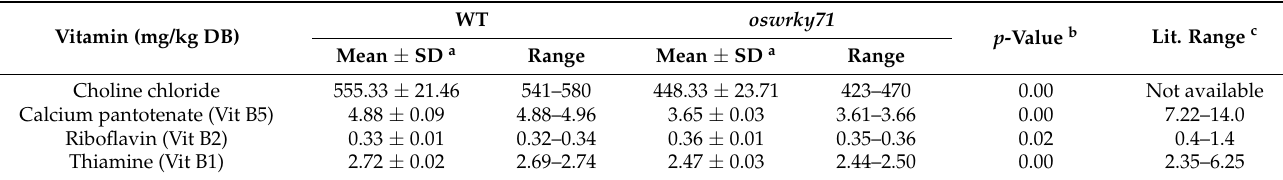
Table 4. Comparison of the B vitamin composition of threshed rice